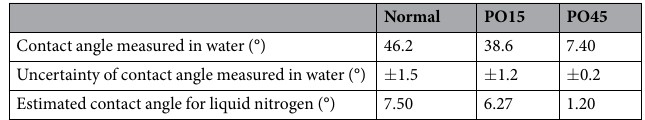
Table 2. Measured contact angles for water and estimated contact angles for LN2.